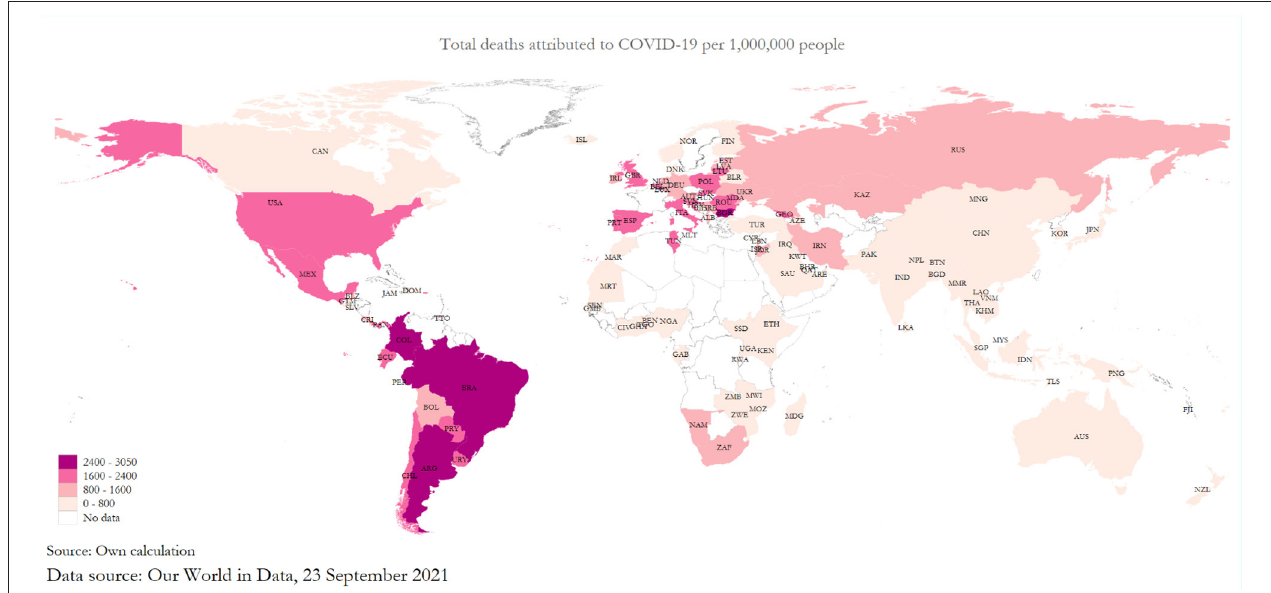
FIGURE 1 | The global death pattern of coronavirus disease-2019